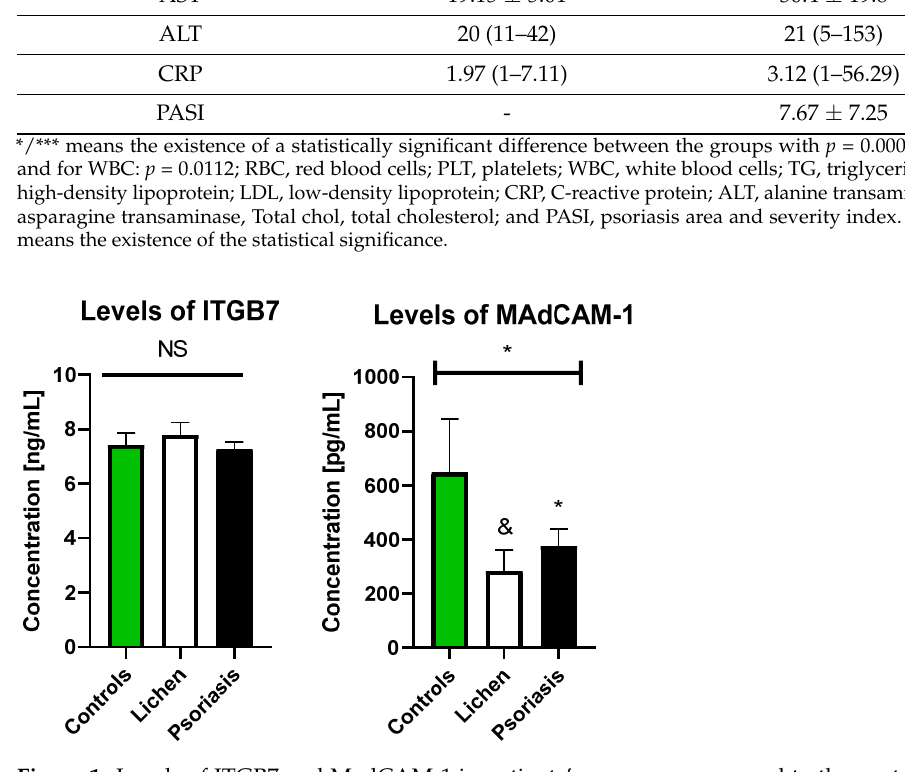
Figure 1. Levels of ITGB7 and MadCAM-1 in patients’ groups as compared to the control group. ANOVA for MAdCAM-1 (all three groups) p = 0.0455; * means controls vs. lichen = 0.088; & means controls vs. psoriasis = 0.041. NS, non-significant.